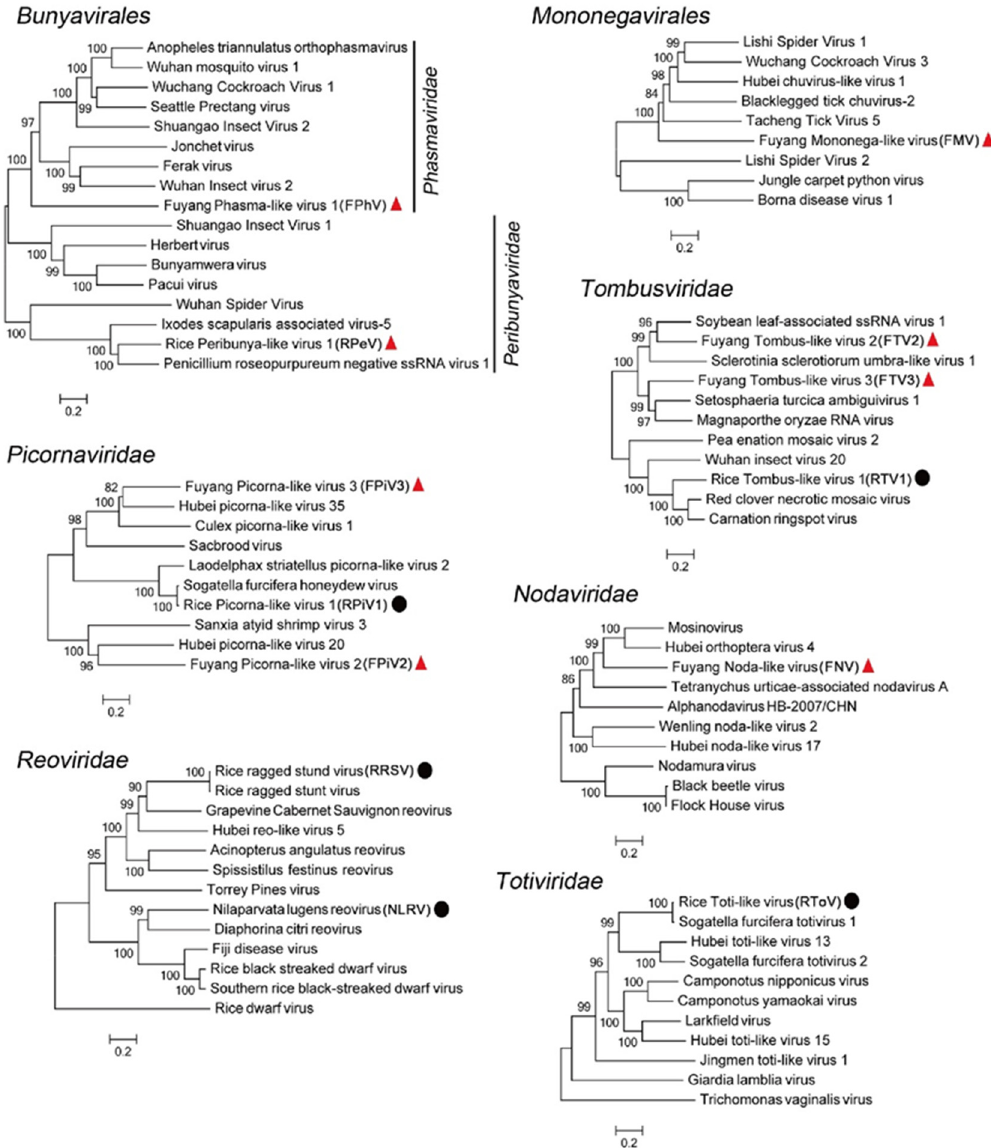
Figure 3. Evolutionary relationship of identified viruses in rice plants Rby1-21 and Rby2-45. The maximum likelihood phylogenetic trees show the position of novel viruses (solid red triangles) and known viruses (solid black circles) in the context of their closest relatives.